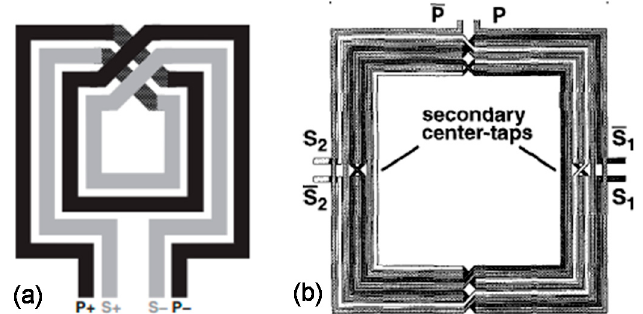
Figure 3. Structure of the interleaved transformer: ( a ) Simple layout of square spiral interleaved two-turn on-chip transformer, reprinted with permission from [63]; ( b ) center-tapped interleaved transformer functioning as a tri-filar balun, reprinted with permission from [4].